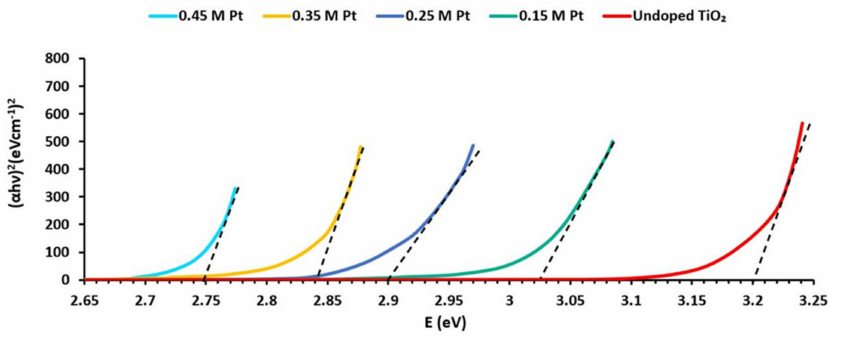
Figure 4. Band gap calculation using the Tauc